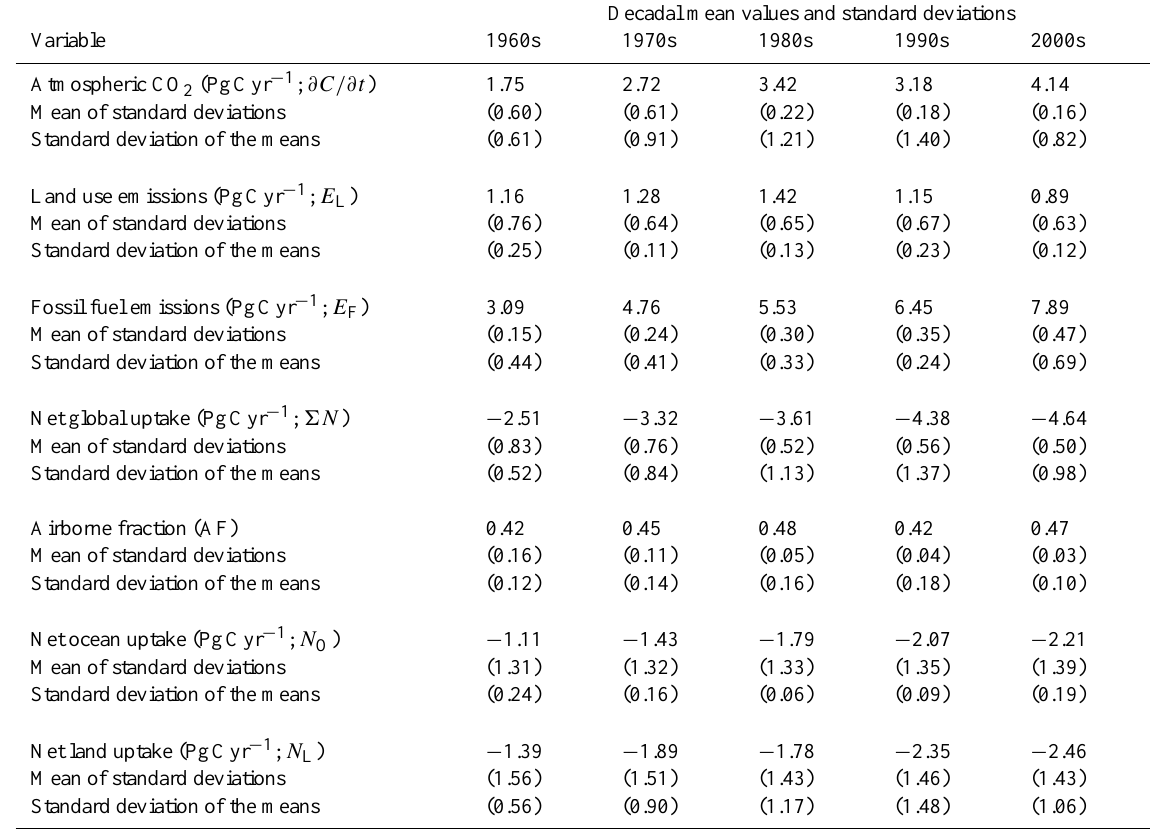
Table 1. Decadal changes in variables of the global C budget. Reported are decadal means for the atmospheric growth rate, land use emissions, fossil fuel emissions, global uptake, the airborne fraction, net ocean uptake, and net land uptake. The first number below the mean (in parentheses) is the mean of the decadal standard deviations that provides a measure of our ability to detect a change in that variable. The second number below the mean (in parentheses) is the standard deviation of the decadal means that provides a measure of variance in that